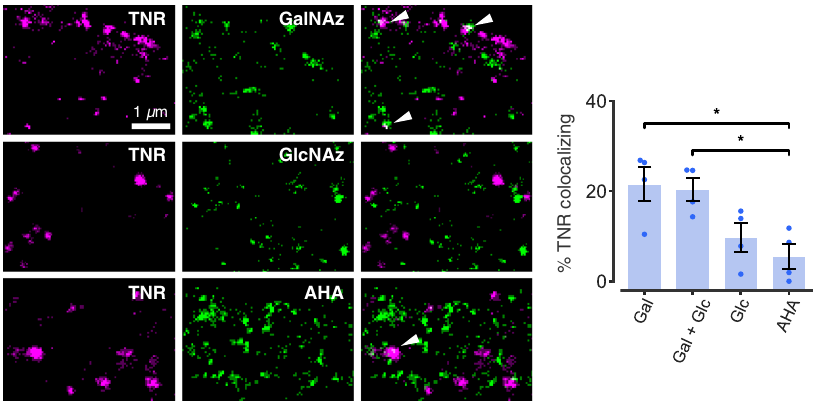
Fig. 8 TNR recycling possibly relates to TNR re-glycosylation. Newly O-glycosylated proteins were labeled by feeding neurons with azide-modi fi ed galactosamine (GalNAz) and/or glucosamine (GlcNAz), which were then revealed by click chemistry. Alternatively, newly-synthesized proteins were labeled by feeding neurons with azidohomoalanine (AHA), which was also tagged using click chemistry. Newly-emerged TNR epitopes were labeled 6 h post-blocking and visualized at the surface. The neurons were imaged with 2-color-STED. Scale bar = 1 µ m. Quanti fi cation of the colocalization of the signals con fi rmed that internalized TNR epitopes colocalize signi fi cantly with GalNAz or GalNAz + GlcNAz, at levels substantially higher than the minimal AHA colocalization, which is not signi fi cantly different from negative controls (relying on non-speci fi c primary antibodies). N = 4 independent experiments, ≥ 10 neurons per datapoint. Kruskal-Wallis test (H = 9.022, *p = 0.029), followed by two-sided Fisher ’ s LSD ( *p = 0.014 and *p = 0.021 for ‘ GalNAz ’ and 3 ‘ GalNAz + GlcNAz ’ respectively). Data represent mean ± SEM, dots indicate individual experiments. Source data are provided in Source Data fi